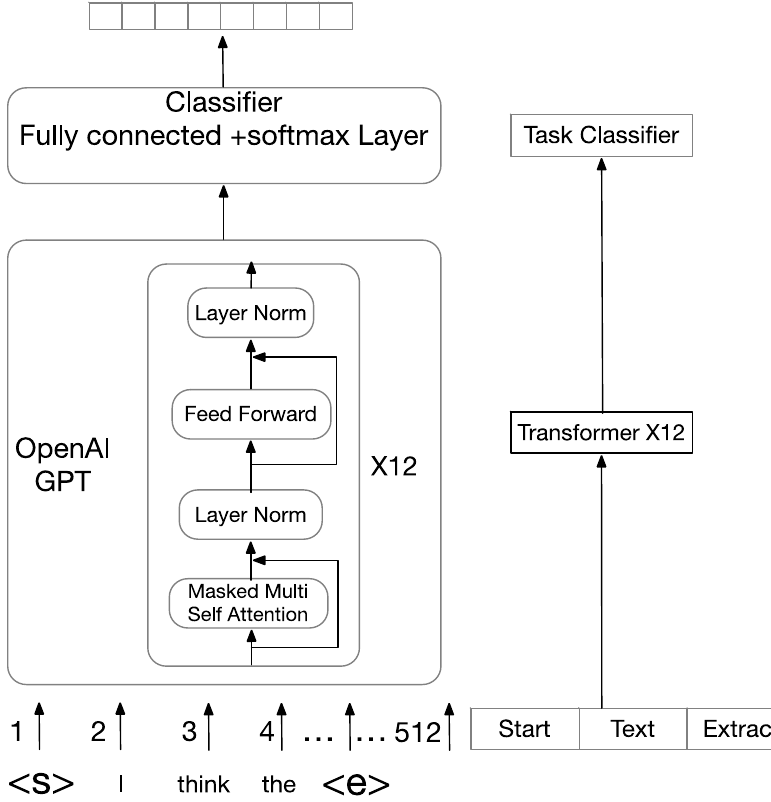
Figure 4. The architecture of fine-tuning generative pre-training (GPT).